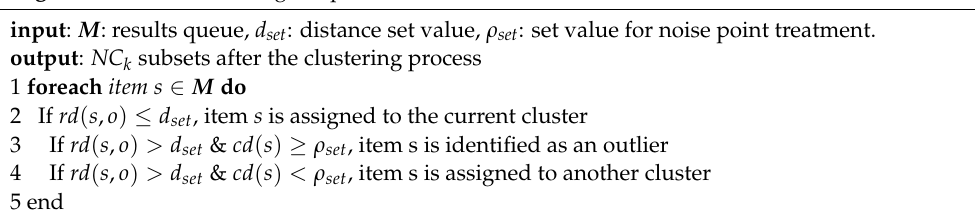
Algorithm 2 The Clustering Subprocedure